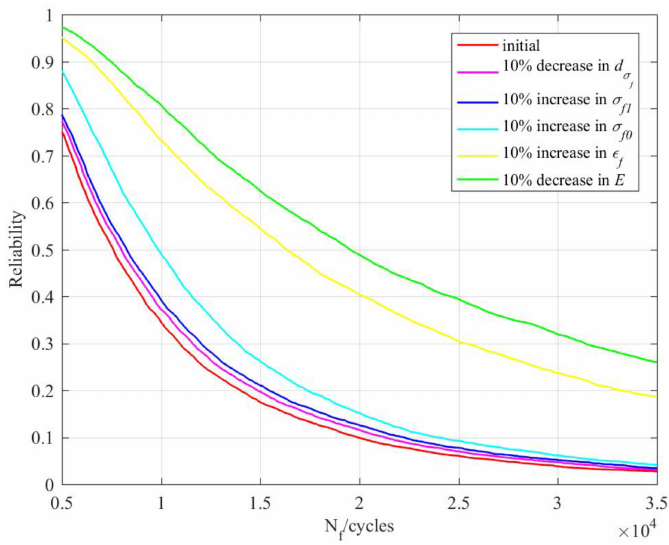
Figure 7. Reliability curves when the material performance parameters